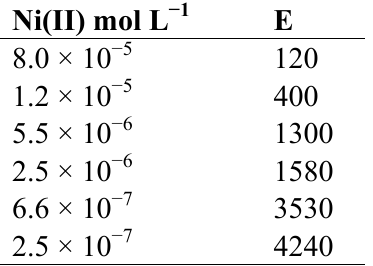
Table 2. Influence of nickel concentration on its enrichment factor. Donor